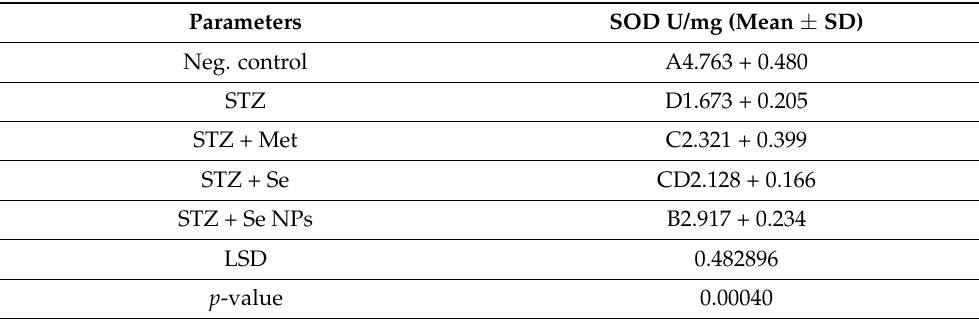
Table 5. The result of the SOD after treatment with